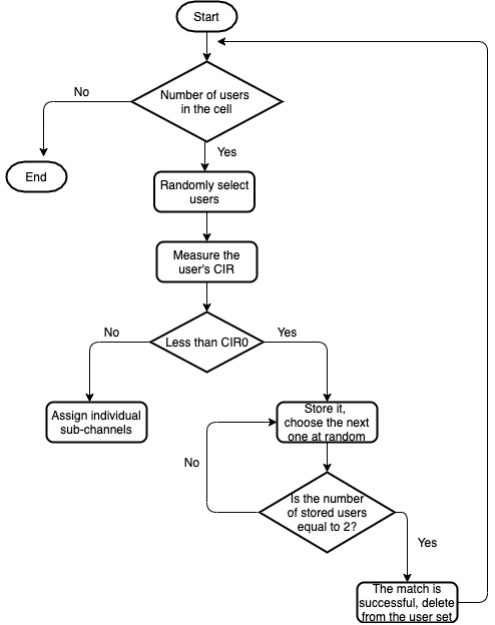
Figure 7. The flowchart of random pairing algorithm.